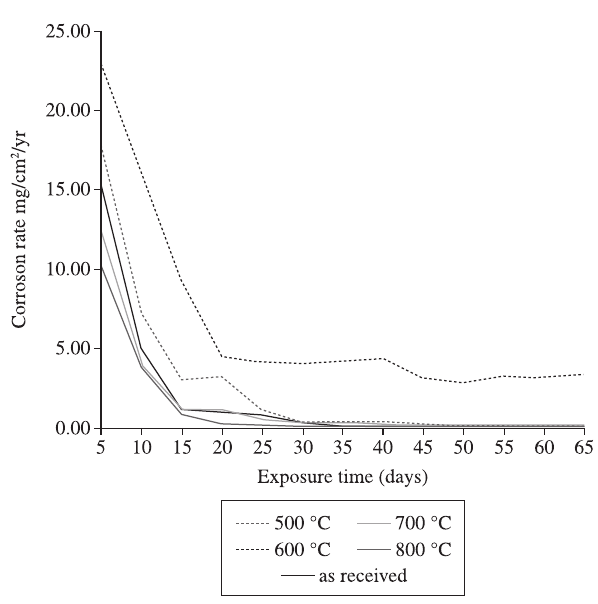
Figure 4. Plot of corrosion rate vs. exposure time of austenitic stainless steel at various post-weld heat